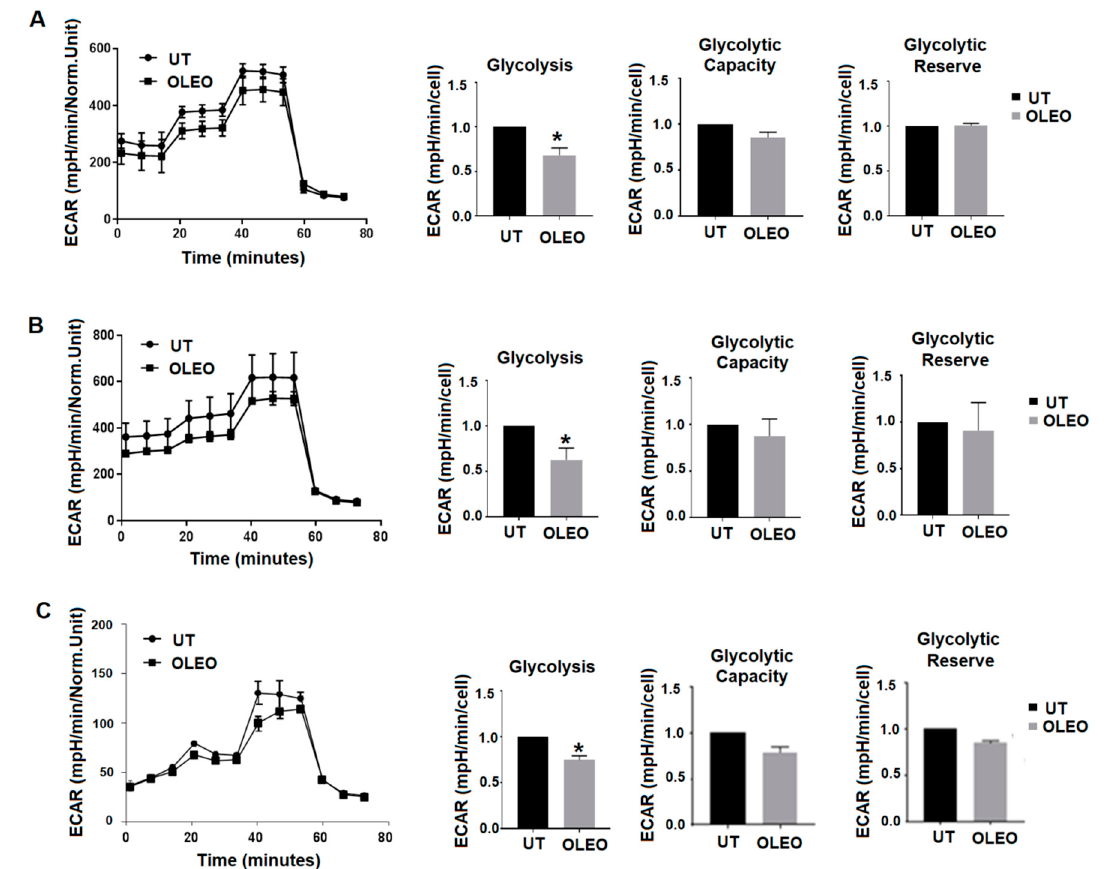
Figure 2. Representative results of a glucose stress test of A375 melanoma cells treated with 200 µ M OLEO ( A ) or 200 µ M Ole ( B ) for 24 h, and of A375-M6 melanoma cells treated with 200 µ M OLEO for 24 h ( C ). Plots on the right represent glycolysis, glycolytic reserve and glycolytic capacity extracted from glycolysis stress assay results obtained using the Seahorse Analyzer. Significance is indicated with *.